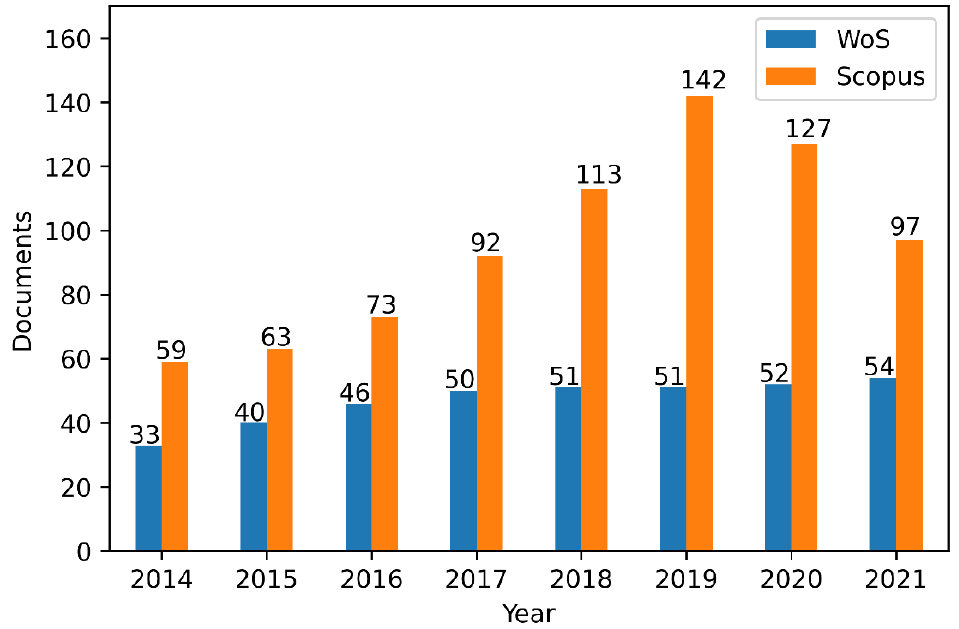
Figure 1. The number of publications in WoS and Scopus each year. Source: Authors’ elaboration.